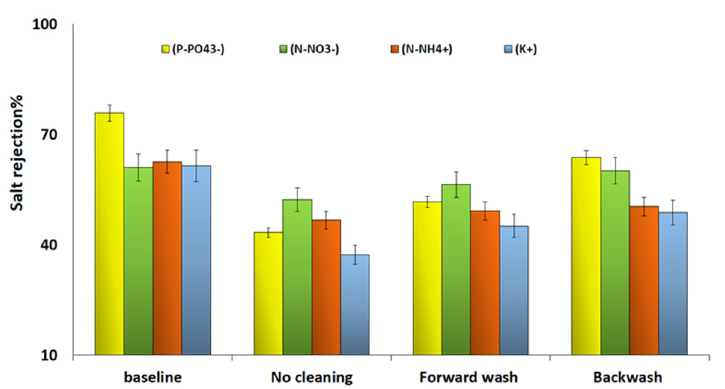
Figure 4. Salt rejection % of P–PO 43 − , N–NO 3 − , N–NH 4 and K + after three consecutive FO runs. Conditions: FS = SWW, DS = MCFDS (300 g / L) and FS and DS flowrate = 1.6 LPM at room temperature for 24 h operating time. Baseline represents the initial FDFO experiment using a new CTA FO membrane, SWW as FS and MCFDS (300g/L) at 1.6LPM for 24 h.